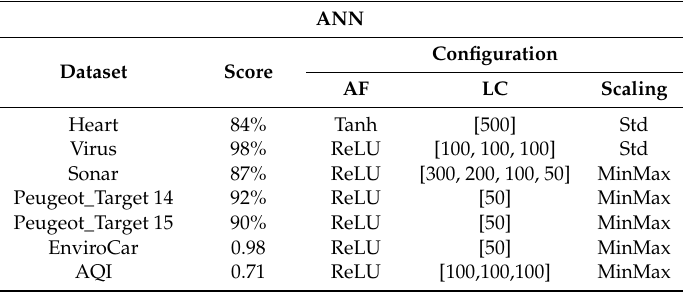
Table 22. ANN performance and configuration for PCA = 30%.